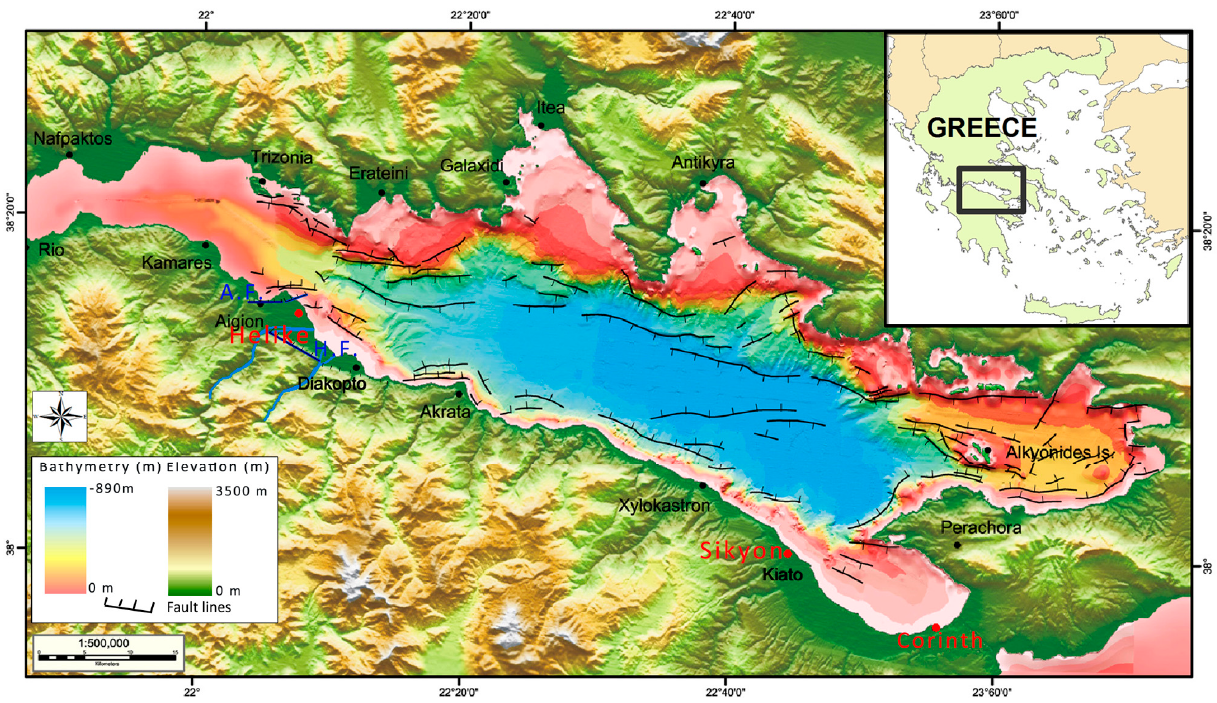
Figure 1. Digital terrain model of the Corinth Gulf showing the offshore and onshore active faults [8–10], the delta plain on which Helike was built, and the harbors of the major coastal cities of that time (Sikyon and Corinth). AF: Aegion and HF: Helike active faults. Inset: Map of Greece showing the study